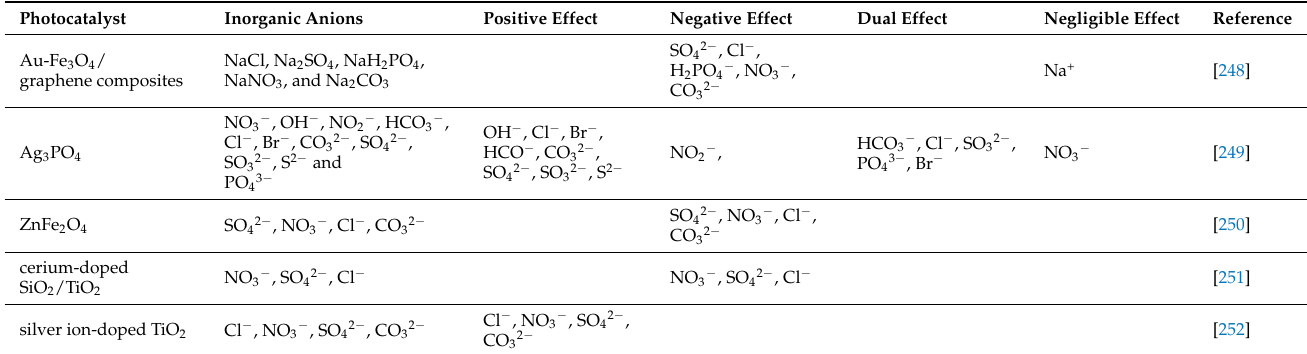
Table 2. The effect of inorganic anions on photodegradation of